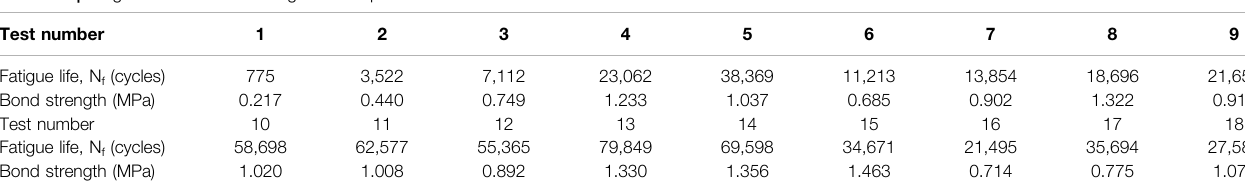
TABLE 6 | Fatigue life and bond strength of composite beams. Test number Fatigue life, N f (cycles)